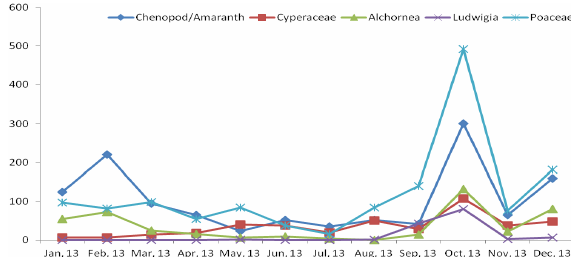
Fig. 4. Abundance of dominant pollen in Shomolu Local